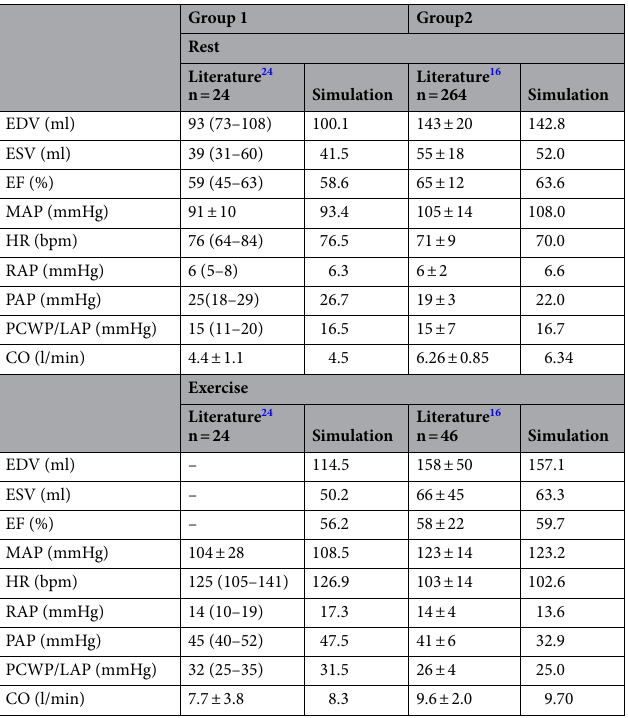
Table 1. Hemodynamics of Groups 1 and 2 at rest and exercise. EDV end diastolic volume, ESV end systolic volume, EF ejection fraction, MAP mean arterial pressure, HR heart rate, RAP right atrial pressure, PAP pulmonary arterial pressure, PCWP pulmonary capillary wedge pressure, LAP left atrial pressure, CO cardiac output.